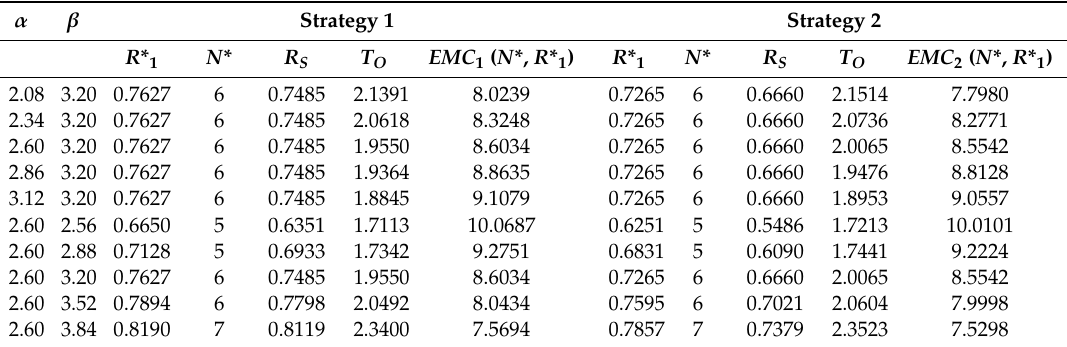
Table 6. Results of sensitivity analysis related to the failure rate’s parameters.